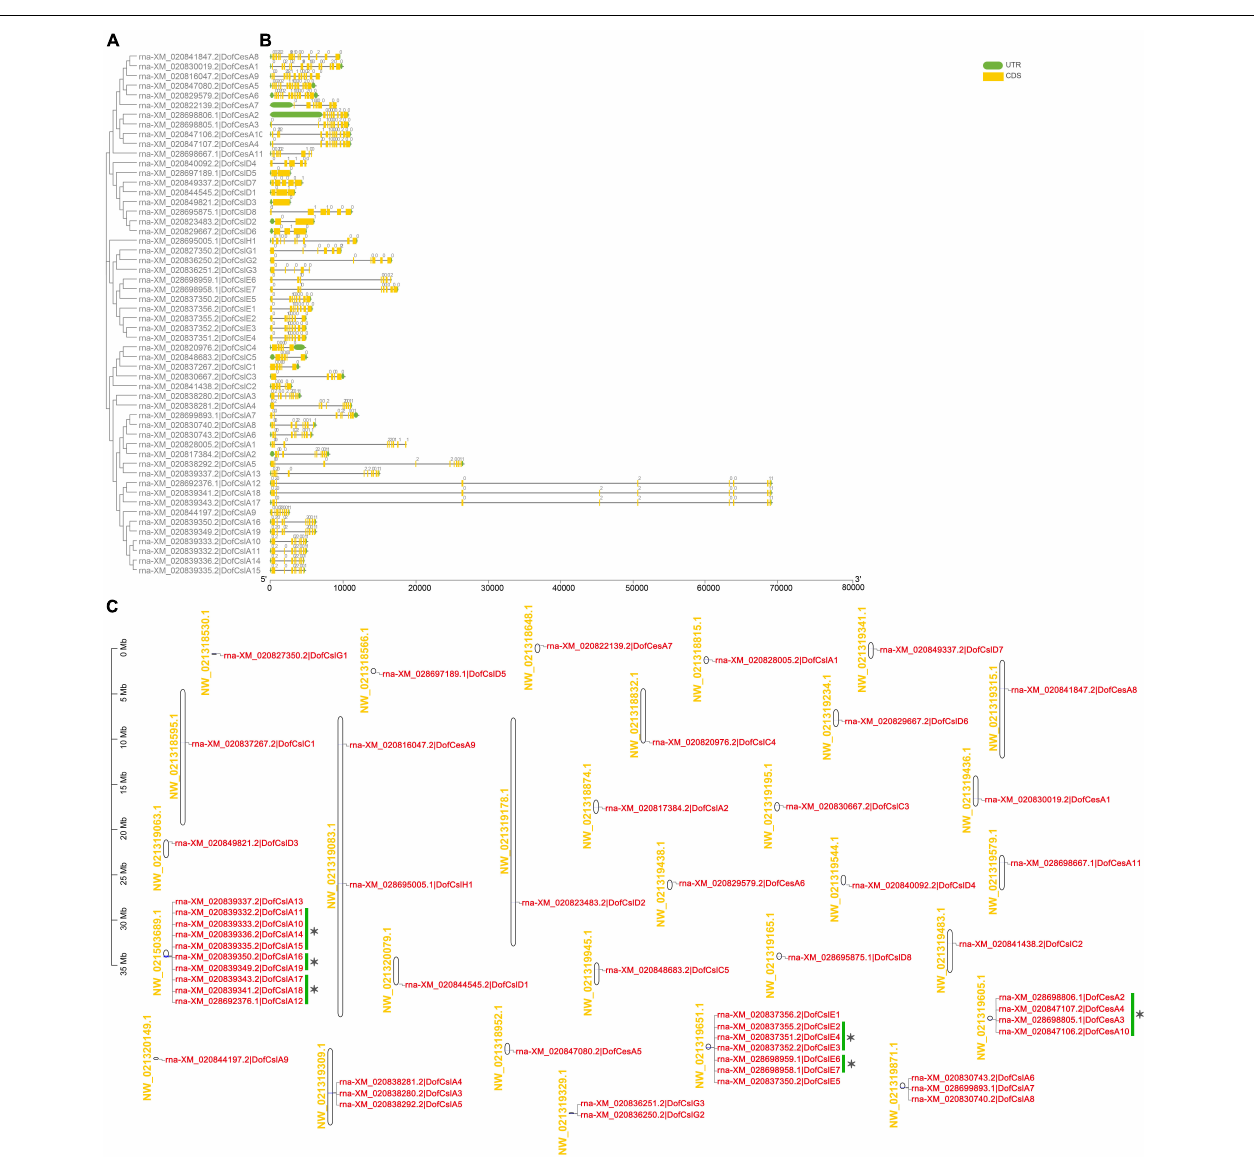
FIGURE 4 | Phylogenetic, gene structure, and distribution analyses of Cellulose synthase superfamily genes in D. officinale ( Dof ). (A) Phylogenetic relationships of the DofCesA/DofCsl genes; (B) Sequence analysis of exon–intron structures of the Cellulose synthase genes. UTRs and exons are indicated using green and yellow rectangles, respectively. The solid lines indicate introns. The numbers above the solid lines represent the intron phase. The scale bar (bp) indicates the length of the corresponding genes; (C) distribution of the Cellulose synthase genes in the D. officinale genome. The scaffold names are shown on the left, and the gene names are on the right. The scale bar (Mb) indicates the length of the corresponding scaffolds. A total of 14 tandemly duplicated genes (with two or more homologous genes ≤ 100 kb apart) were found. Green scale bars and asterisks indicated alternative splicing